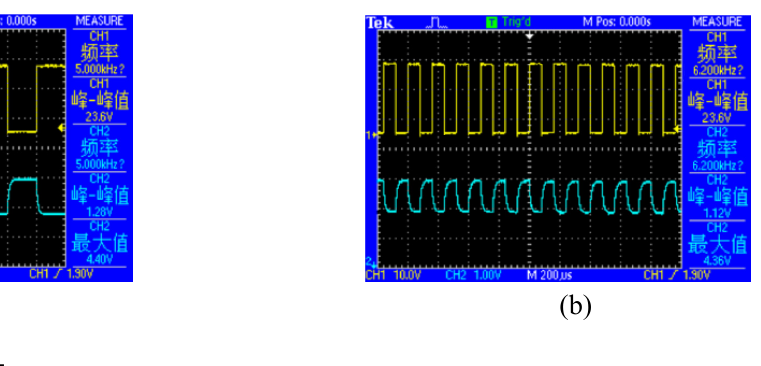
Figure 11 . GLM response characteristics. (a) Response characteristics of the GLM actuated by a 5 KHz frequency square-wave. (b) Response characteristics of the GLM actuated by a 6.2 KHz frequency